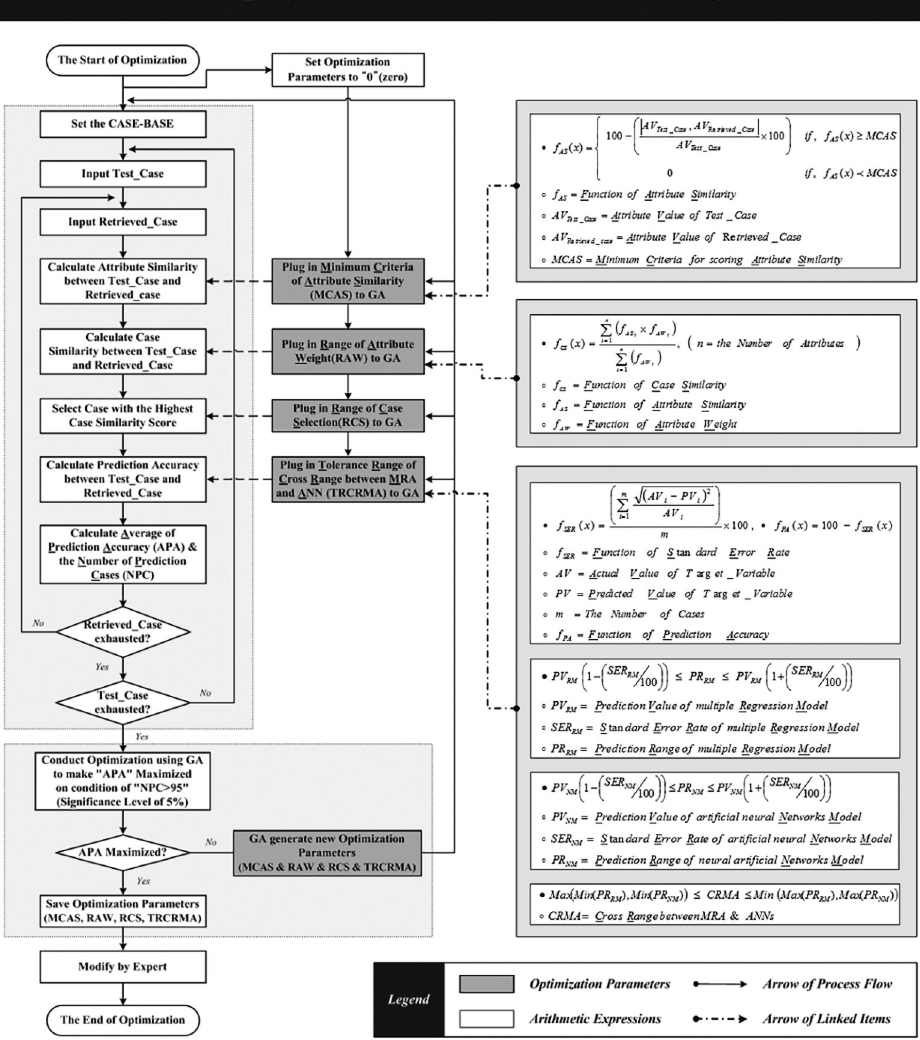
Fig. 4. A process for developing an A-CBR model (refer to Koo et al.